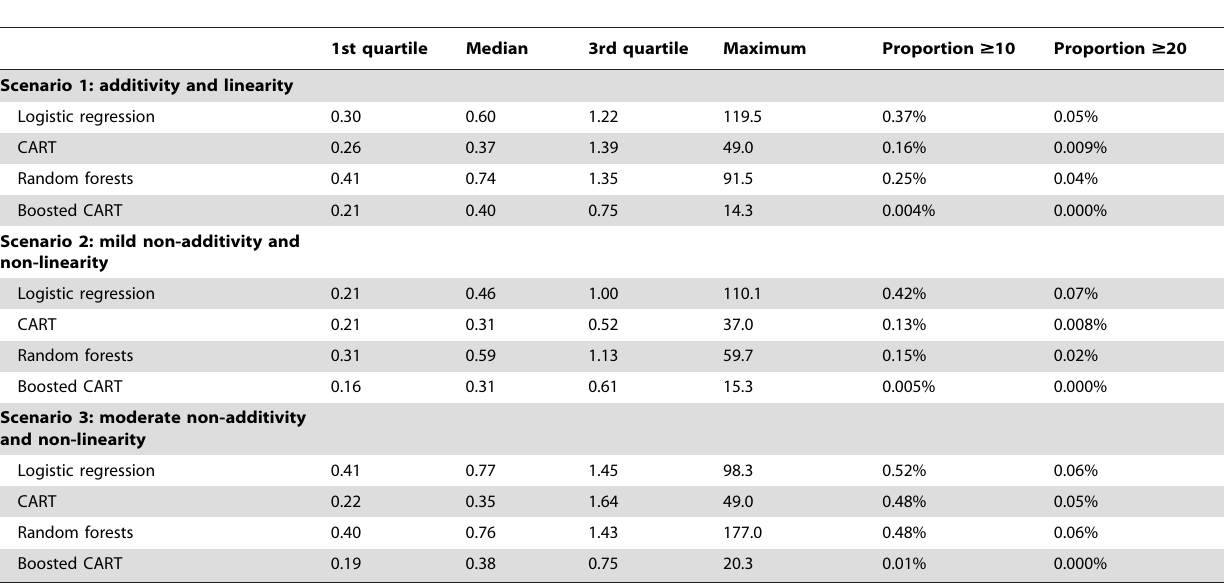
Table 1. Distribution of Propensity Score Weights for the Unexposed Group by Estimation Method and True Propensity Score Model Scenario.